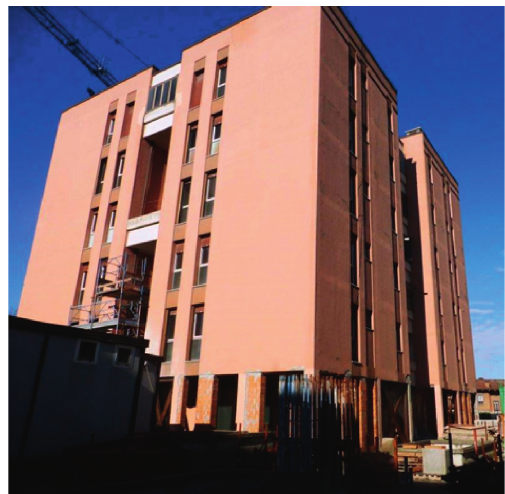
Figure 1: External view of the case study